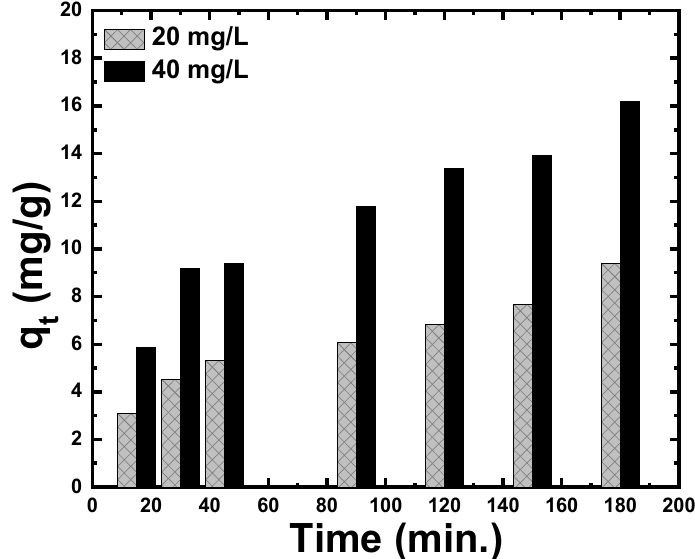
Figure 5. Adsorption capacity ( q t ) of CR dye on the ZnS nanoparticles at different shaking times and different initial concentrations.